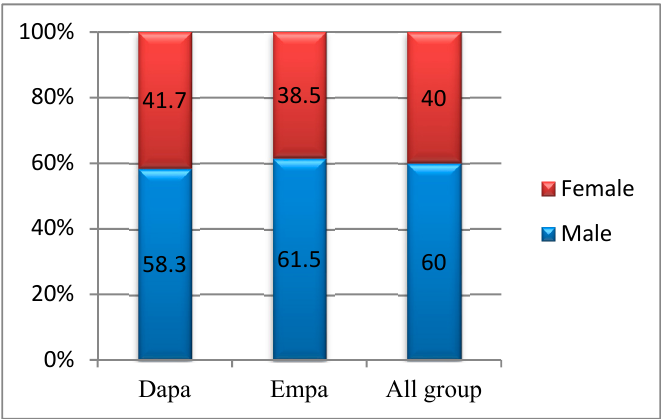
Figure 2. Group distribution by gender.